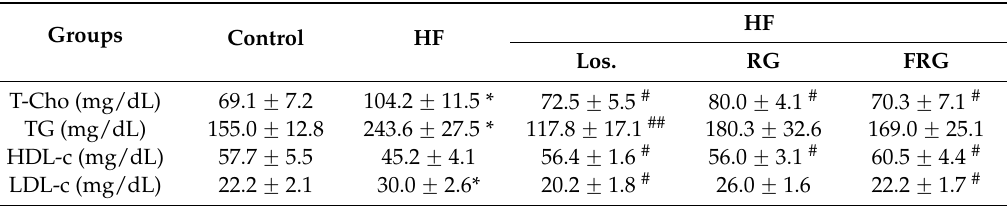
Table 2. Effect of FRG on plasma lipids.